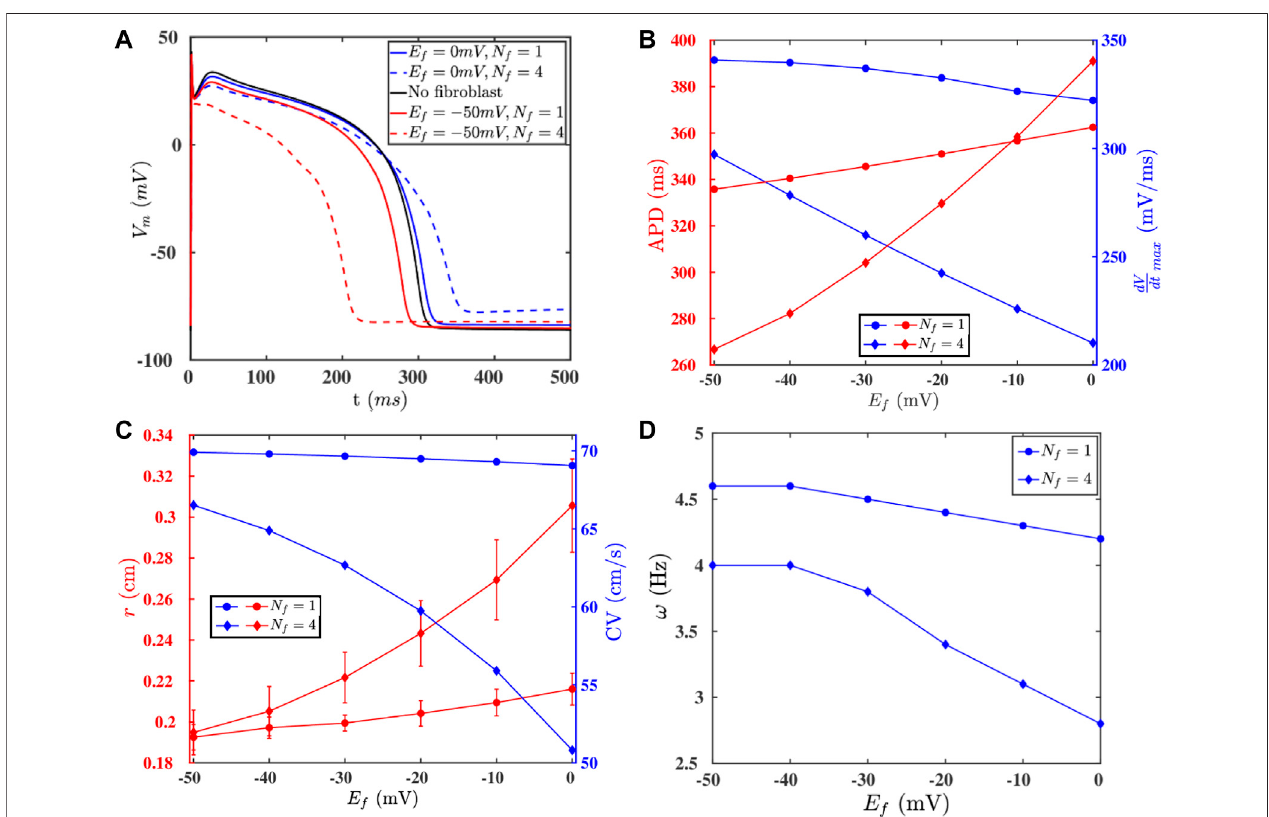
FIGURE5|(A) APs of an isolated myocyte (black -) and a myocyte coupled to fi broblasts with various paramters: E f (cid:1) 0 mV, N f (cid:1) 1 (blue -); E f (cid:1) 0 mV, N f (cid:1) 4 (blue - -); E f (cid:1) − 50 mV, N f (cid:1) 1 (red -); E f (cid:1) − 50 mV, N f (cid:1) 4 (red - -). (B) The values of the APD and dV dtmax for different values of E f and two different values of N f . (C) The values of r and CV for different values of E f and two different values of N f . (D) The varition of ω with changes in E f for two different values of N f